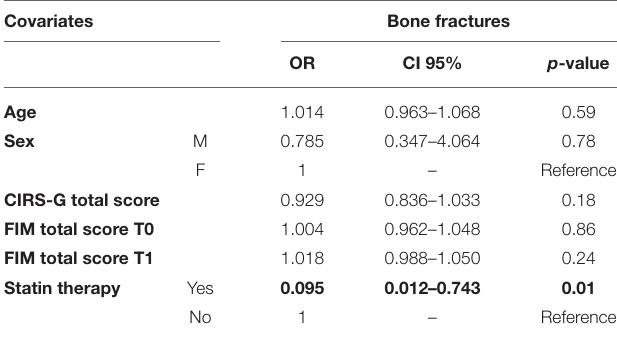
TABLE 3 | Multinomial regression model evaluating the negative association between statin therapy and bone fractures.